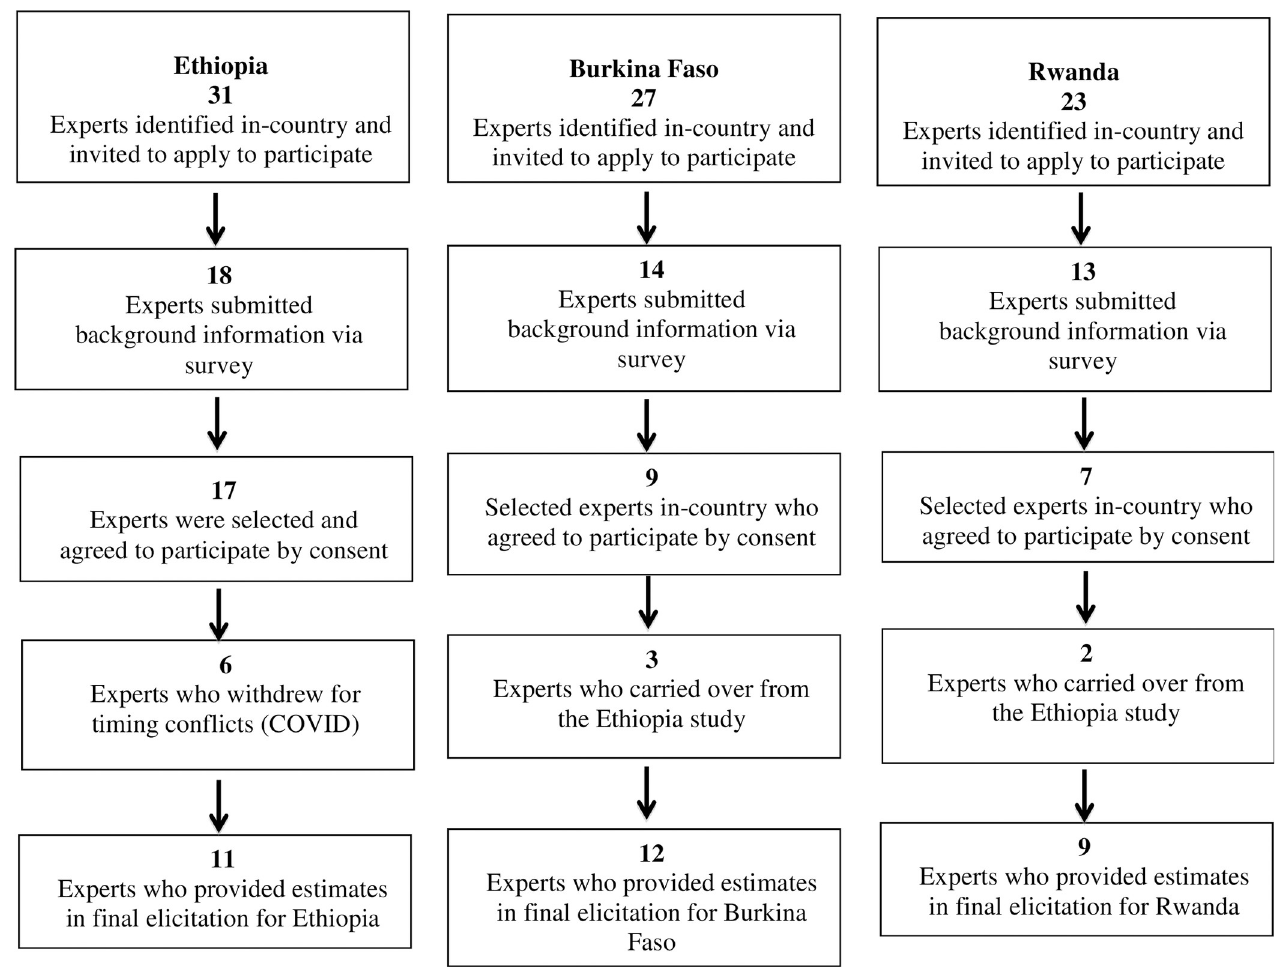
Fig 2. Expert identification, selection and enrollment for three African Structured Expert Judgment studies.